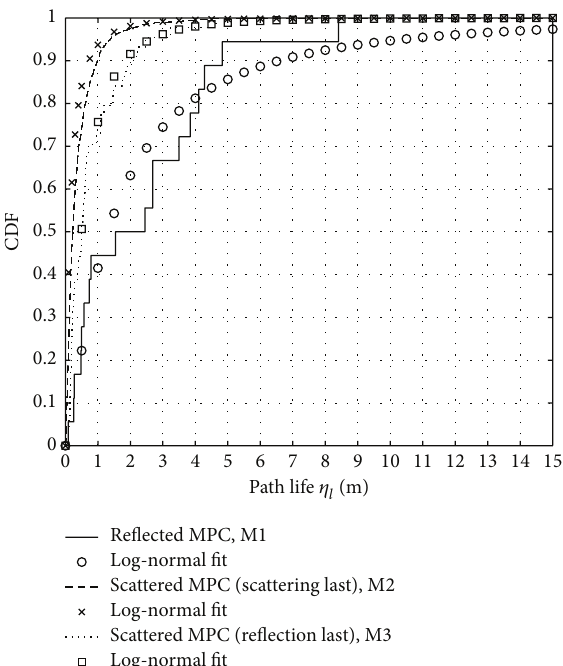
Figure 11: CDF of the path life 𝜂 𝑙 for Scenario-1. The 𝑝 values based on the KS test are 0.48 for type M1 MPC, 0.74 for M2, and 0.73 for